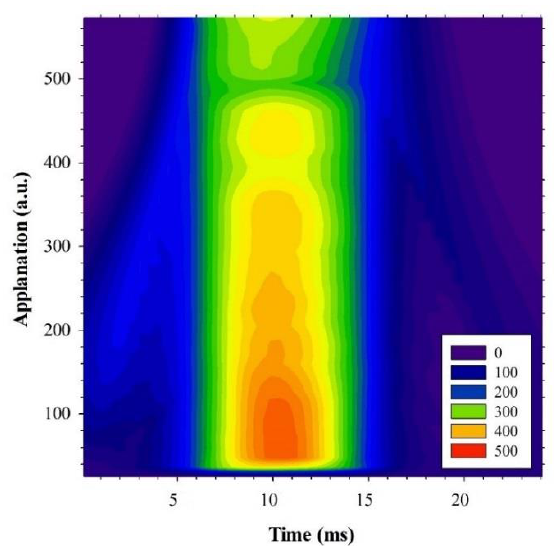
Figure 6. Dynamical representation of corneal applanation as a function of time from a volunteer of the study. Air pulse pressure is scaled in arbitrary units and shown in the bottom right corner leg- end.